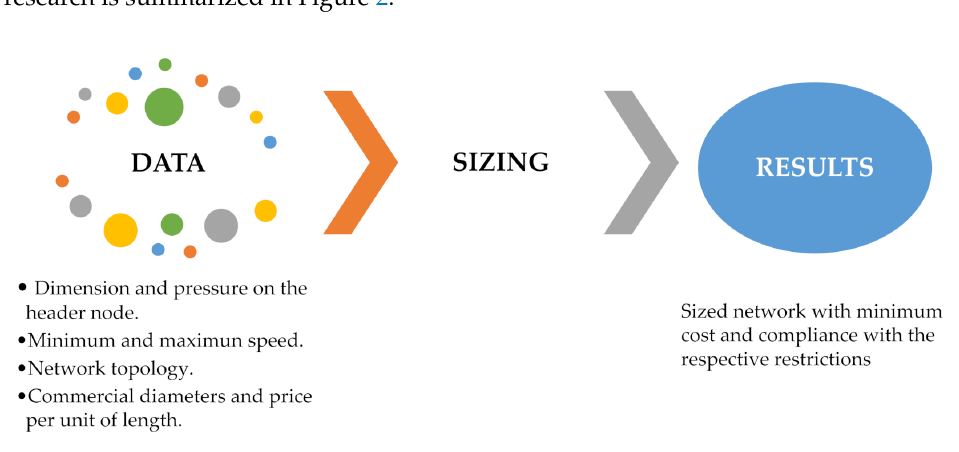
Figure 2. Process for optimal design with